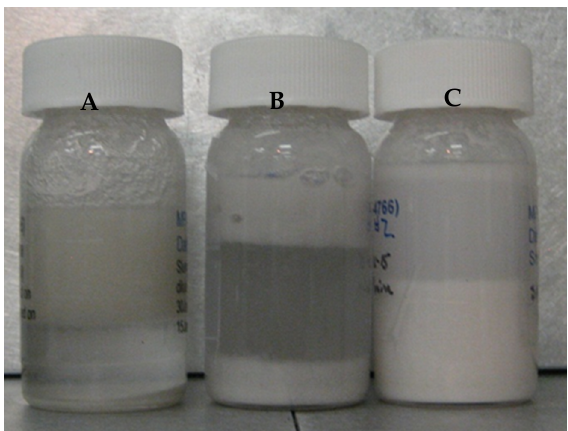
Figure 16. Ammonia borane slurry stratification based on the extent of ammonia borane conversion of as-prepared silicone oil-based ammonia borane slurry ( A ), partially reacted AB-Si oil slurry ( B ), and ( C ) >90% ammonia borane conversion.